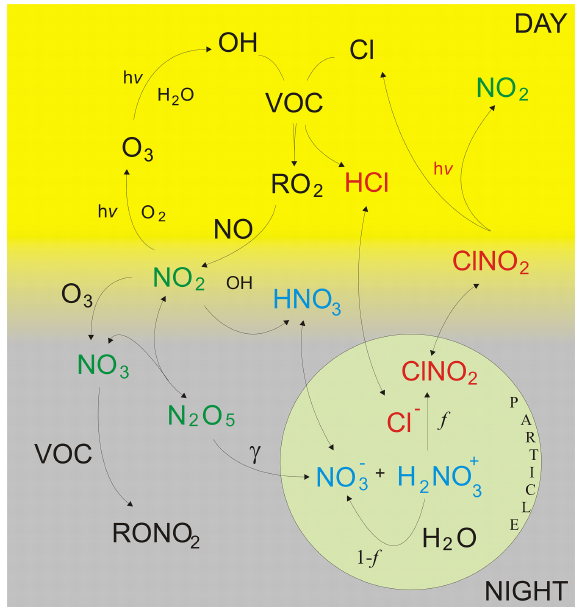
Figure 1. Gas- and aqueous-phase chemical processes forming ClNO 2 and particulate nitrate indicating the role of ClNO 2 in mod- ifying the effect of N 2 O 5 uptake on the chemical lifetime of NO x and photochemical RO 2